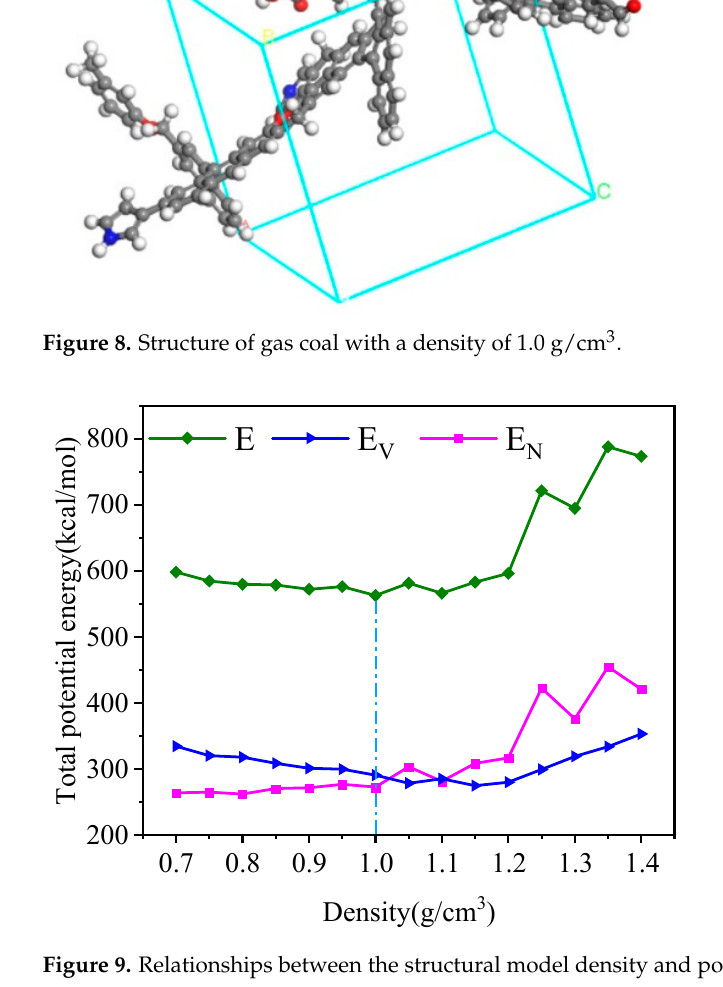
Figure 9. Relationships between the structural model density and potential energy .